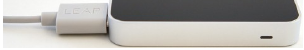
Fig. 1: The Leap Motion device.